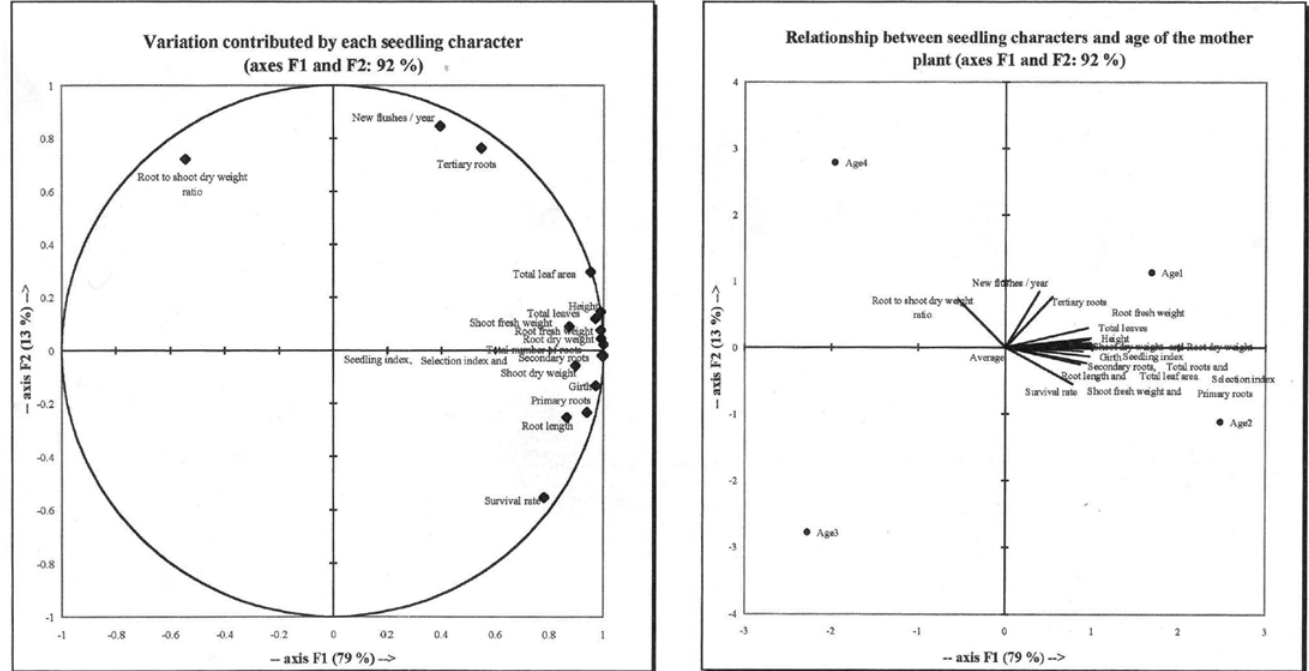
Fig. 4 - Plot showing the percentage of variation contributed by each seedling character and the relationship between age of the mother plant and seedling characters in mangosteen ( Garcinia mangostana